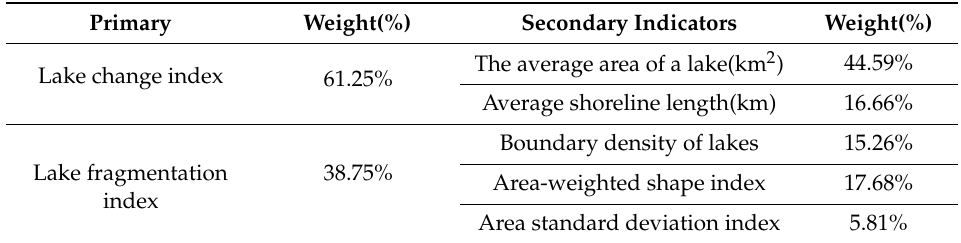
Table 3. System of lake changes